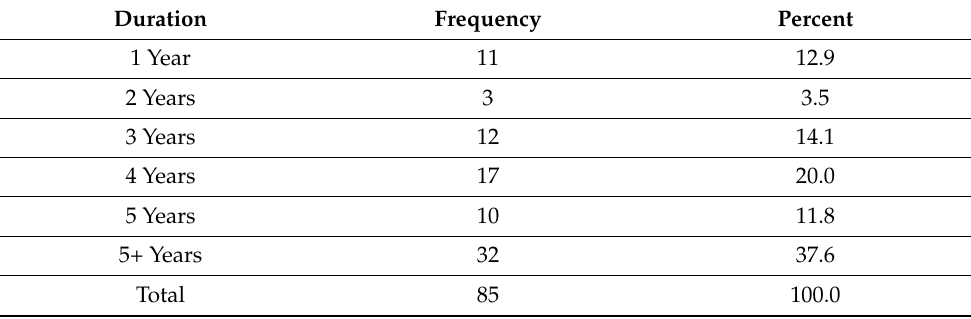
Table 6. Participation time of individuals with ASD in APA.